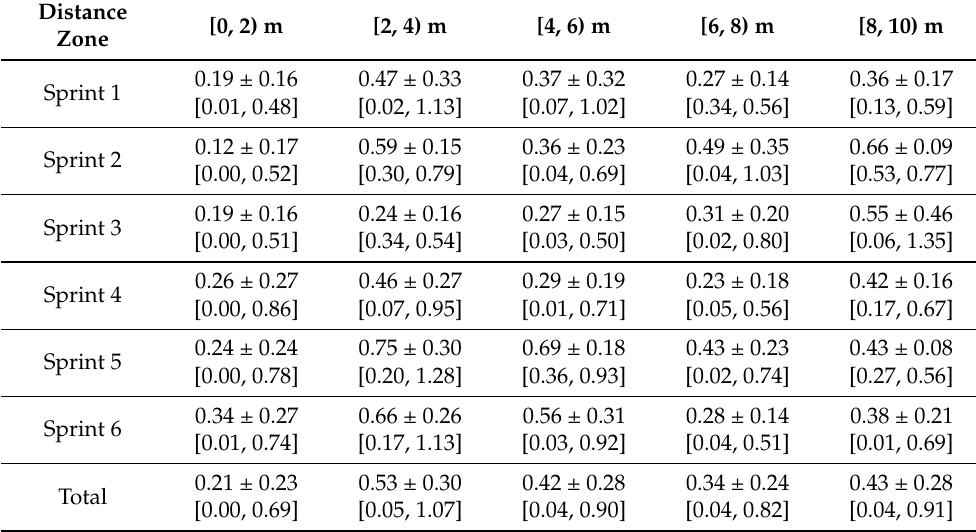
Table 2. Speed error (m · s − 1 ) (mean ± standard deviation, [5%, 95% quantiles]): comparison with Vicon